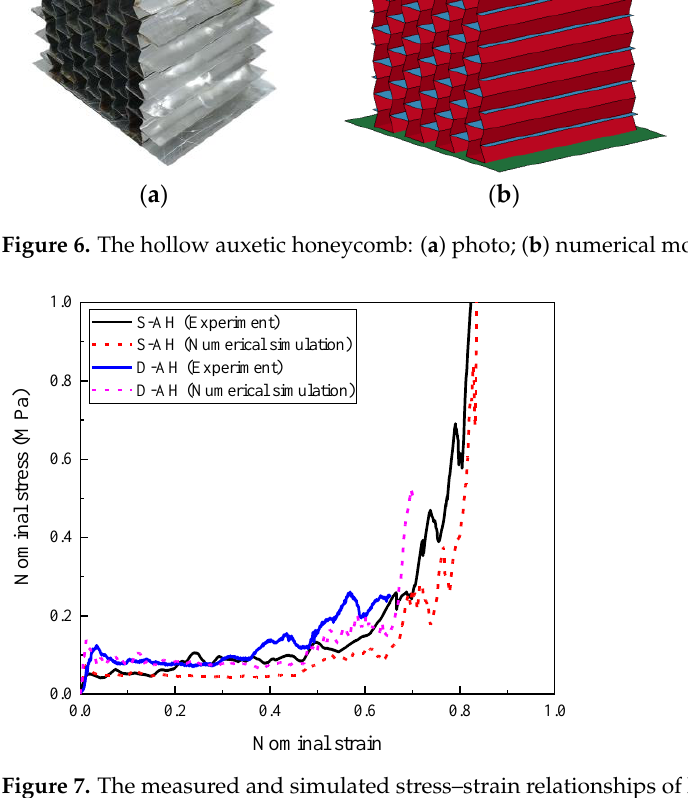
( b ) Figure 8. The auxetic honeycomb filled with foam concrete: ( a ) photo; ( b ) numerical model.